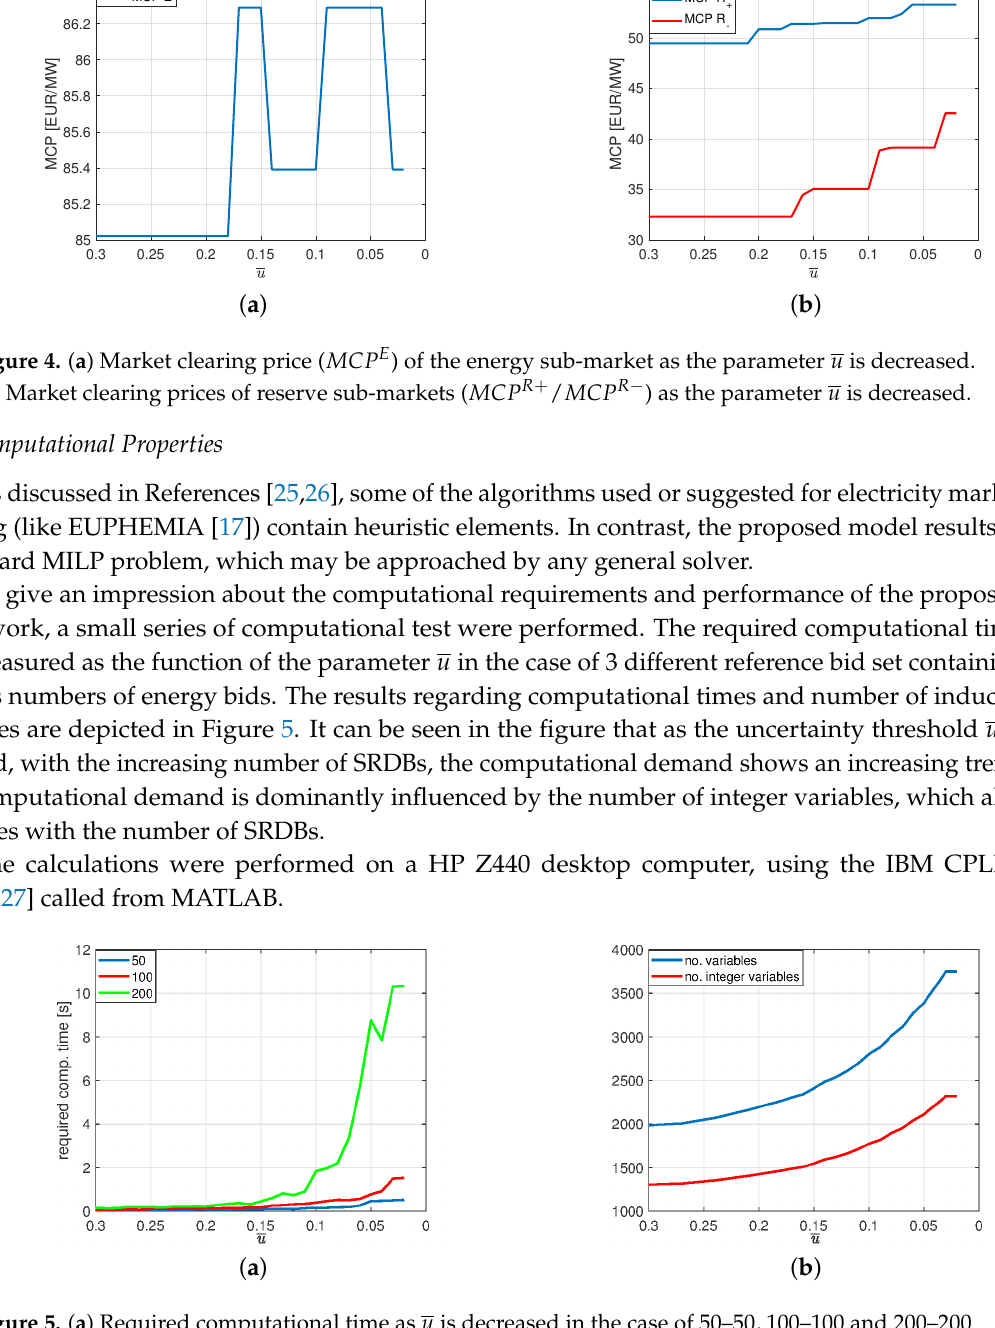
Figure 5. ( a ) Required computational time as u is decreased in the case of 50–50, 100–100 and 200–200 energy supply and demand bids (with similar uncertainty parameters as in the case of the previous example detailed in Appendix A). ( b ) Number of variables and integer variables in the 200 bids